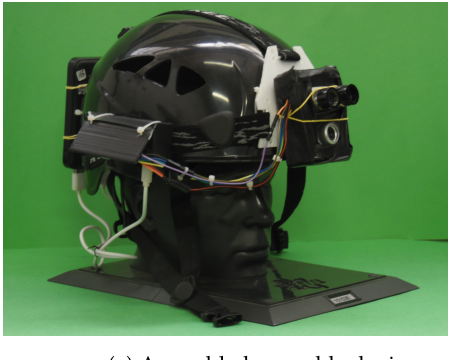
Figure 5. Prototype